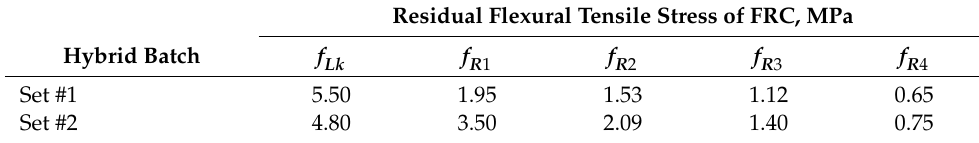
Table 4. Residual flexural tensile strength of FRC.